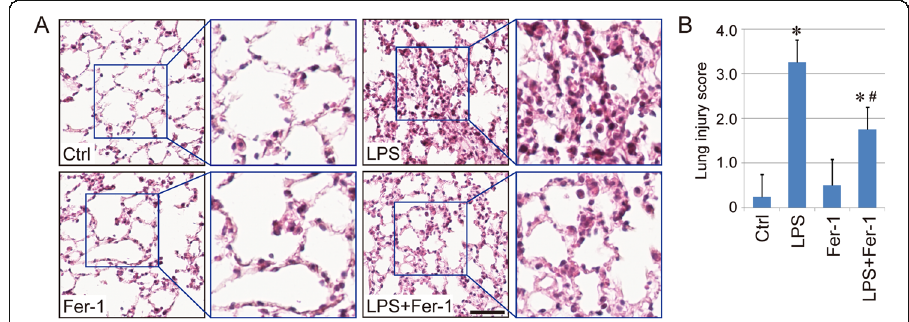
Fig. 4 Therapeutic action of Fer-1 against LPS-induced ALI. a . Hematoxylin and eosin (HE) staining of lung tissue sections from different groups (Scale bar = 50 μ m). The raw images of HE staining are shown in Supplementary Fig. 2. b . Lung injury score of mice in each group. Results are expressed as means±SEM ( n = 4). *: p < 0.05 compared with the control group. #: p < 0.05 compared with the LPS group